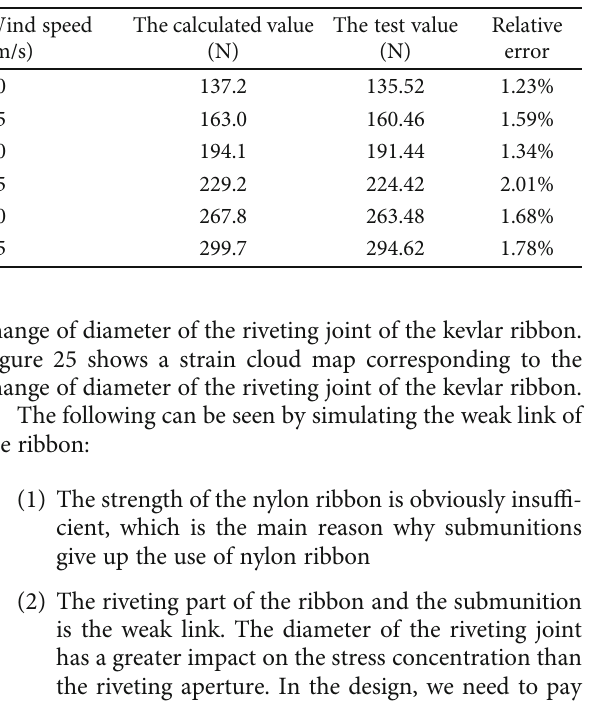
Table 11: The calculated value and test value of the